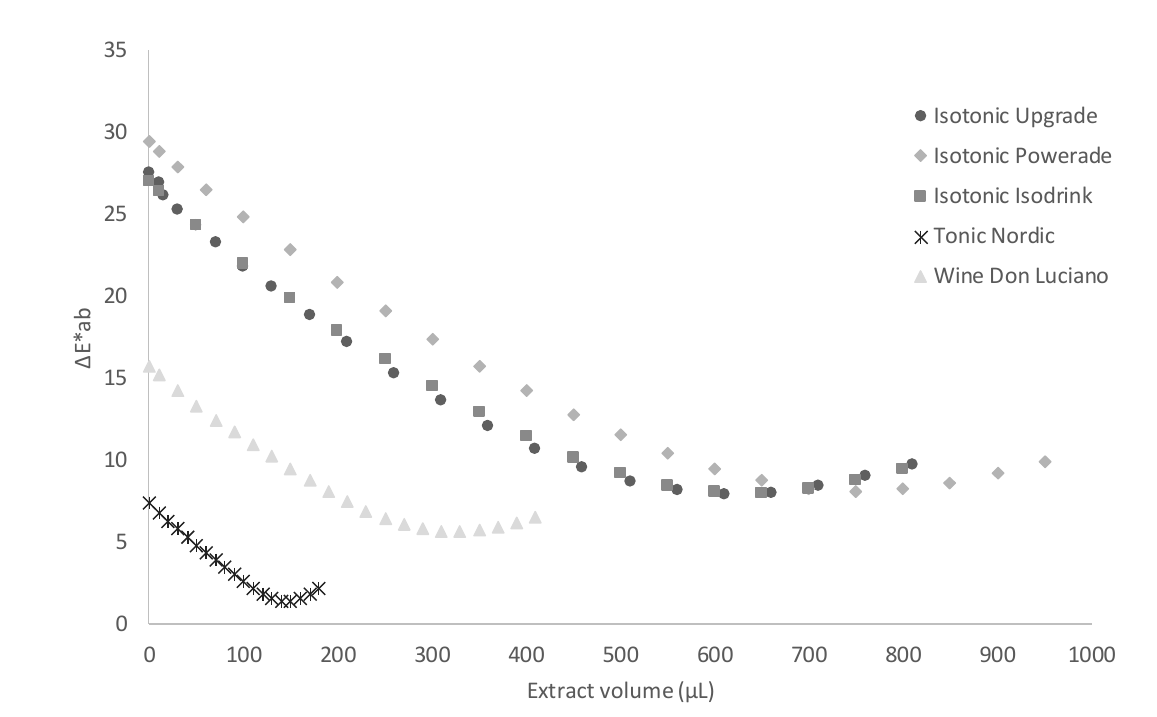
Figure 3. Colouring curves of beverages obtained from colouring assays using the C-PC extract from Oscillatoria sp. ([C-PC] extract = 2.08 mg mL − 1 ).